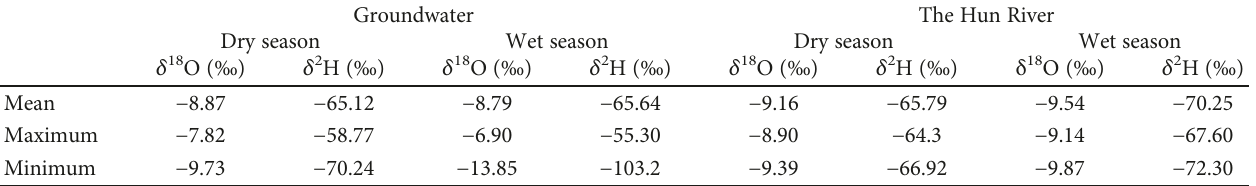
( ‰ ) and δ 2 H ( ‰ ) values of groundwater and river water in the study area. water water